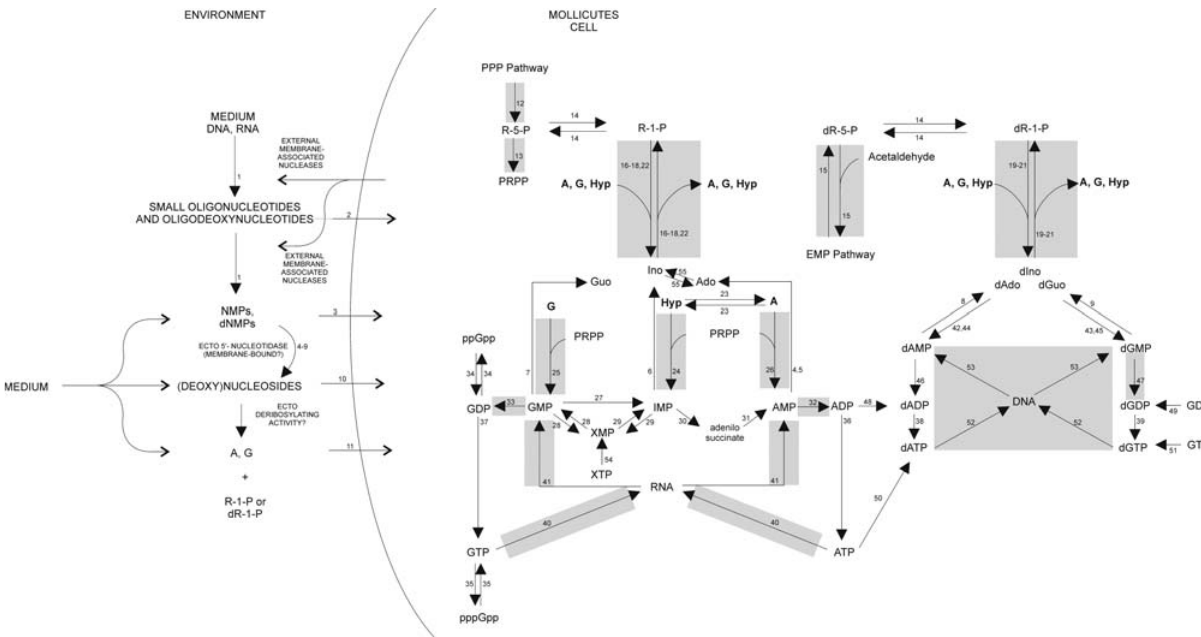
Figure 1 -Schematic representation of purine nucleotide metabolic pathways found or suggested to be present in Mollicutes. The reaction pathways added in this representation were experimentally reported and/or a gene coding the putative corresponding enzyme was annotated in at least one of the 12 genome-sequenced mollicutes analyzed in this work. For reactions shown in gray we have found the corresponding CDS in all mollicutes except Onion Yellow Phytoplasma (for some of these CDSs an orthologue was also identified in this Phytoplasma). Enzyme activities: 1, membrane-associated nu- cleases (RNAses and DNAses); 2, oligo(deoxy)nucleotide transporter; 3, (d)NMP uptake; 4, AMP phosphatase (non-specific); 5, AMP phosphatase; 6, IMP phosphatase; 7, GMP phosphatase; 8, dAMP phosphatase; 9, dGMP phosphatase; 10, (deoxy)nucleoside uptake; 11, nucleobase uptake; 12, Ribose-5-phosphate isomerase; 13, Ribose-phosphate pyrophosphokinase; 14, phosphopentomutase; 15, Deoxyribose-5-phosphate aldolase; 16, adeno- sine phosphorylase; 17, guanosine phosphorylase; 18, inosine phosphorylase; 19, deoxyadenosine phosphorylase; 20, deoxyguanosine phosphorylase; 21, deoxyinosine phosphorylase; 22, inosine nucleosidase (without PO4); 23, adenine deaminase; 24, hypoxanthine phosphoribosyltransferase; 25, gua- nine phosphoribosyltransferase; 26, adenine phosphoribosyltransferase; 27, GMP reductase; 28, GMP synthase; 29, inosine 5’-monophosphate dehydrogenase; 30, adenylosuccinate synthetase; 31, adenylosuccinate lyase; 32, AMP kinase (adenylate kinase); 33, GMP kinase (guanylate kinase); 34, ppGpp 3’-pyrophosphohydrolase; 35, GTP diphosphokinase; 36, ADP kinase; 37, GDP kinase; 38, dADP kinase; 39, dGDP kinase; 40, RNA poly- merase;41,RNAse;42,deoxyadenosinekinase(ATP-dependent);43,deoxyguanosinekinase(ATP-dependent);44,deoxyadenosinekinase(PPi-depen- dent); 45, deoxyguanosine kinase (PPi-dependent); 46, dAMP kinase; 47, dGMP kinase; 48, ribonucleoside-diphosphate reductase - ADP reductase; 49, ribonucleoside-diphosphate reductase - GDP reductase; 50, ribonucleoside-triphosphate reductase (RTR) - ATP reductase; 51, ribonucleoside- triphosphate reductase (RTR) - GTP reductase; 52, DNA polymerase; 53, DNAse; 54, xanthosine triphosphate pyrophosphatase; 55, adenosine